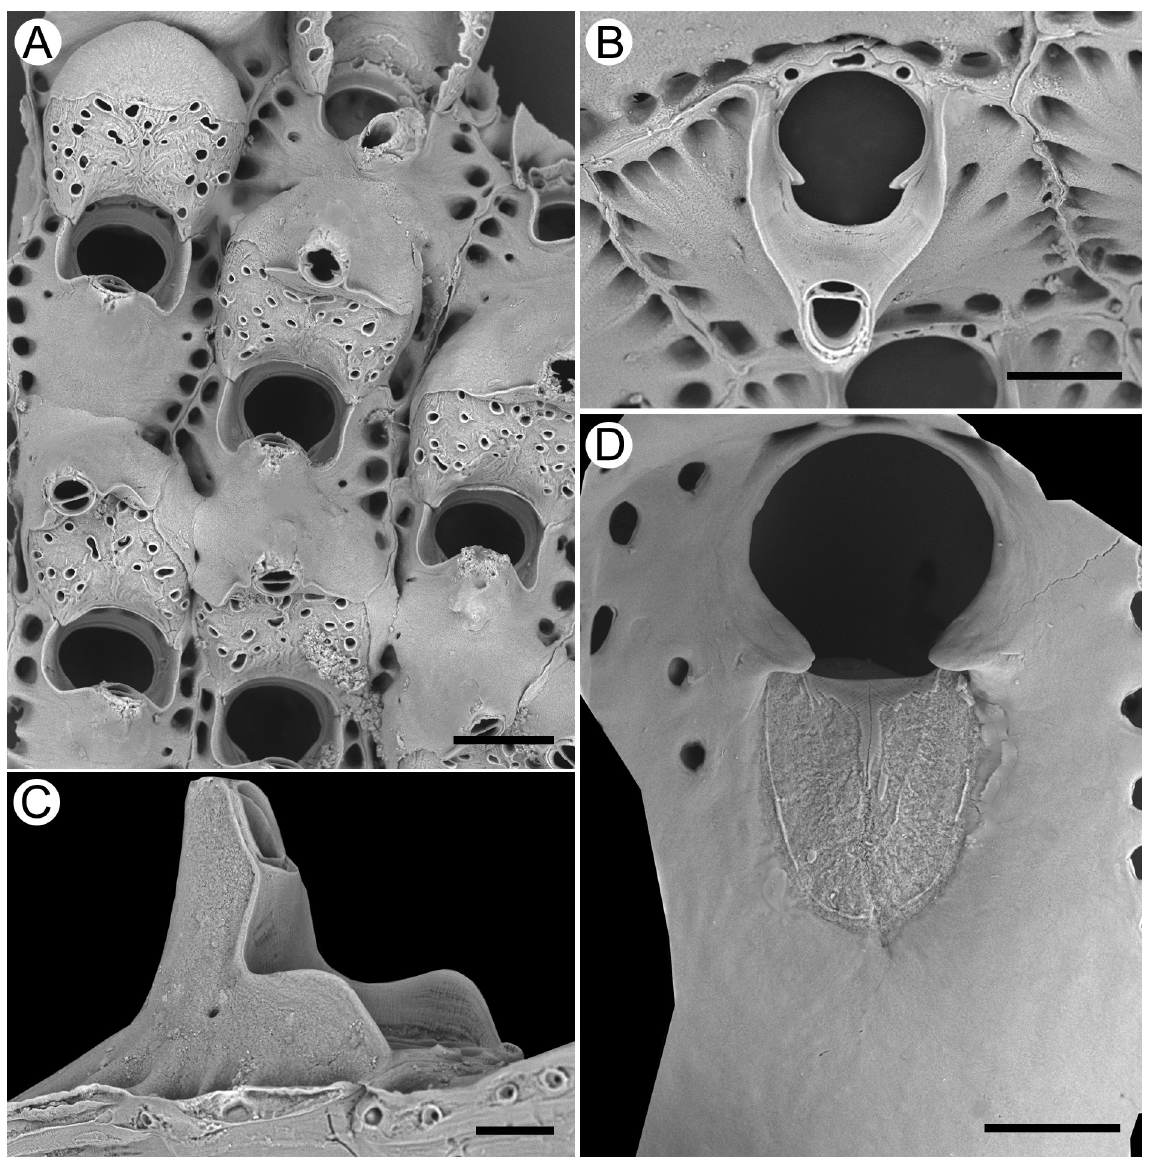
Fig. 2. Parkermavella columnaris sp. nov., holotype (NIWA 97418), Recent, inferred greater Cook Strait, New Zealand. A . Group of ovicellate zooids. B . Tilted close-up of an autozooid showing the broadly cleithridiate (keyhole shaped) orifice, four distal oral spines, two of which coalescent, and the suboral avicularium with complete cross-bar. C . Lateral view of the columnar peristome bearing the suboral avicularium. D . Inner view of the frontal shield showing the umbonuloid area and ring scar. Scale bars: A = 250 µm; B = 100 µm; C–D = 50